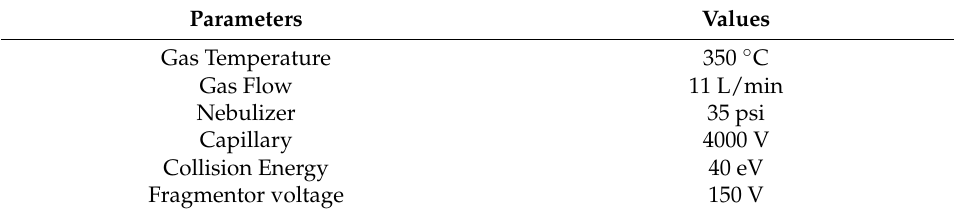
Figure 2. Daughter ion spectra of MG along with the possible fragmentation pattern. Table 1. MS parameter for the detection of precursor and the daughter